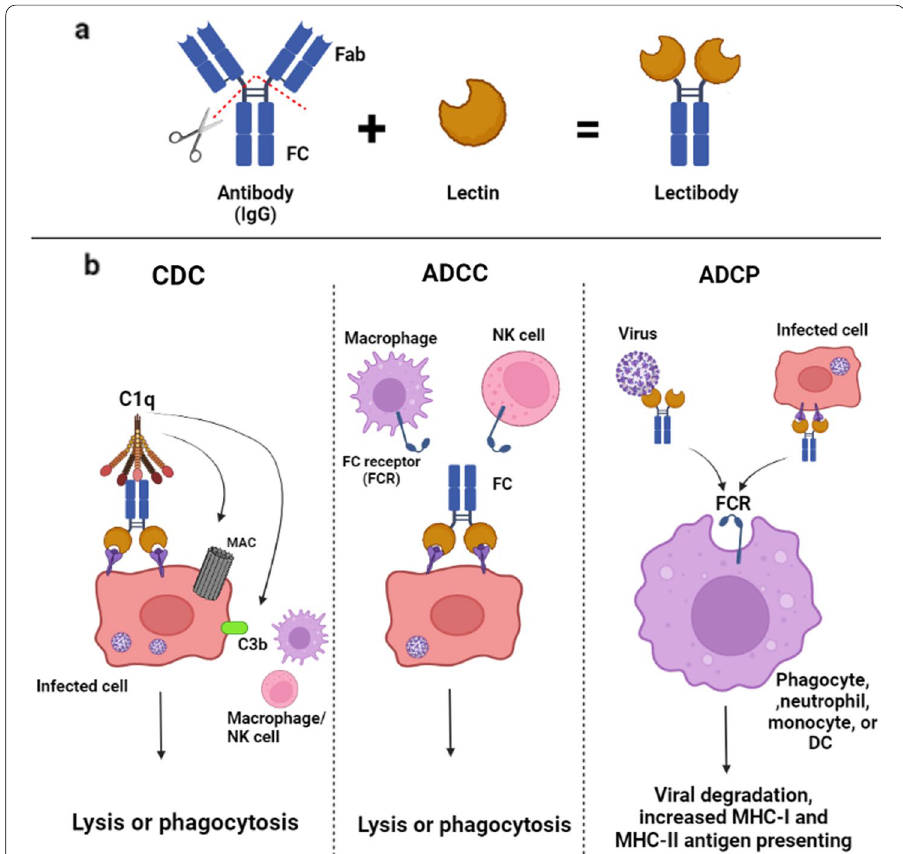
Fig. 4 a Fusion of lectin and antibody’s crystallizable fragment (Fc) of immunoglobulin G (IgG) produces a molecule called a “lectibody.” b Lectibodies can bind to surface glycoproteins via their lectins, neutralize viruses or cells infected by viruses, and help the innate and adaptive immune systems function against pathogens through functions including complement‑dependent cytotoxicity (CDC), antibody‑dependent cell‑mediated cytotoxicity (ADCC), and antibody‑dependent cell‑mediated phagocytosis